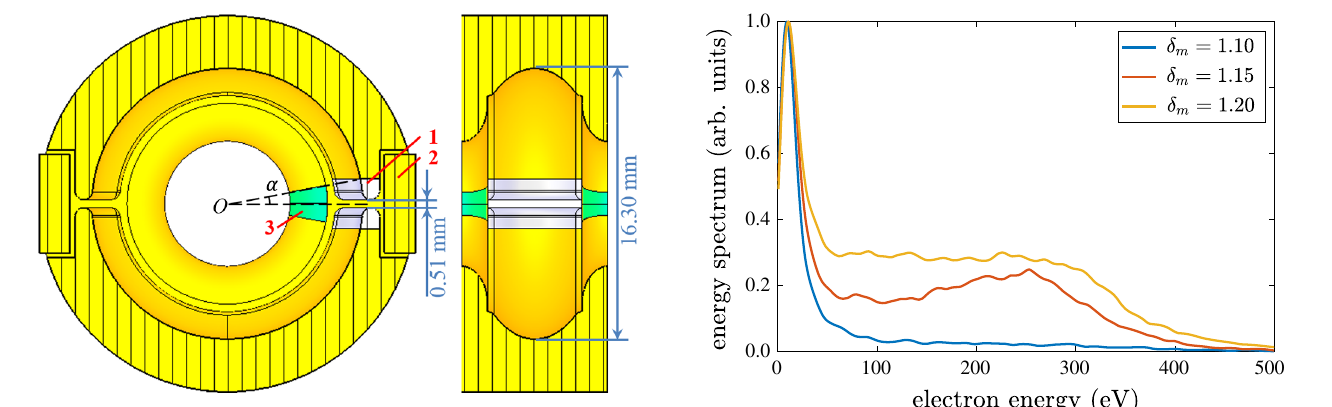
FIG. 8. Side dark current electron energy spectrum calculation results in arbitrary units (arb. units) from CST PIC simulations for δ ¼ 1 . 10 , 1.15 and 1.20 assigned to the sidewall section for the m SEE